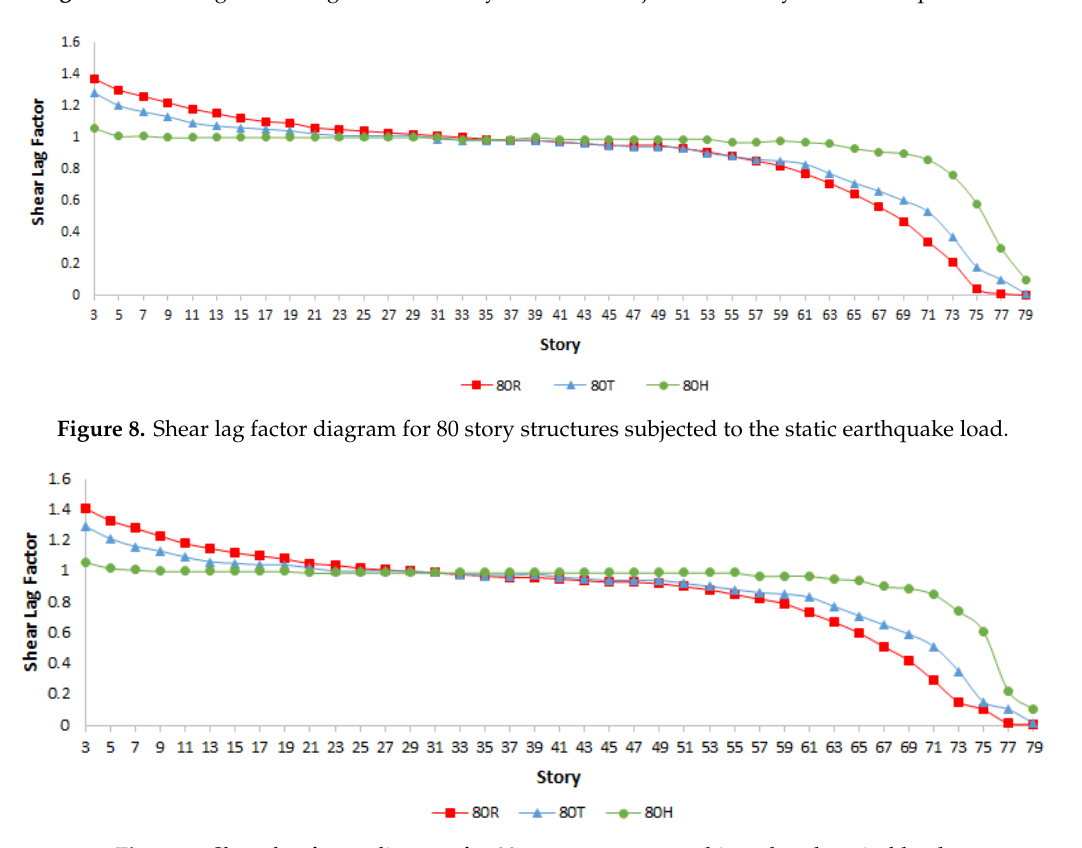
Figure 9. Shear lag factor diagram for 80 story structures subjected to the wind load.